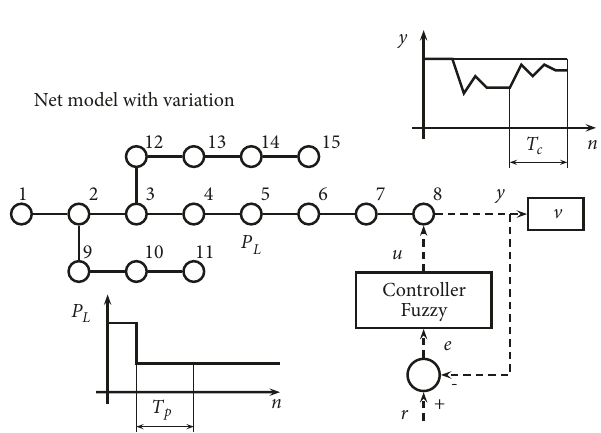
Figure 8: Operation of the system after the respective controller adjustment.